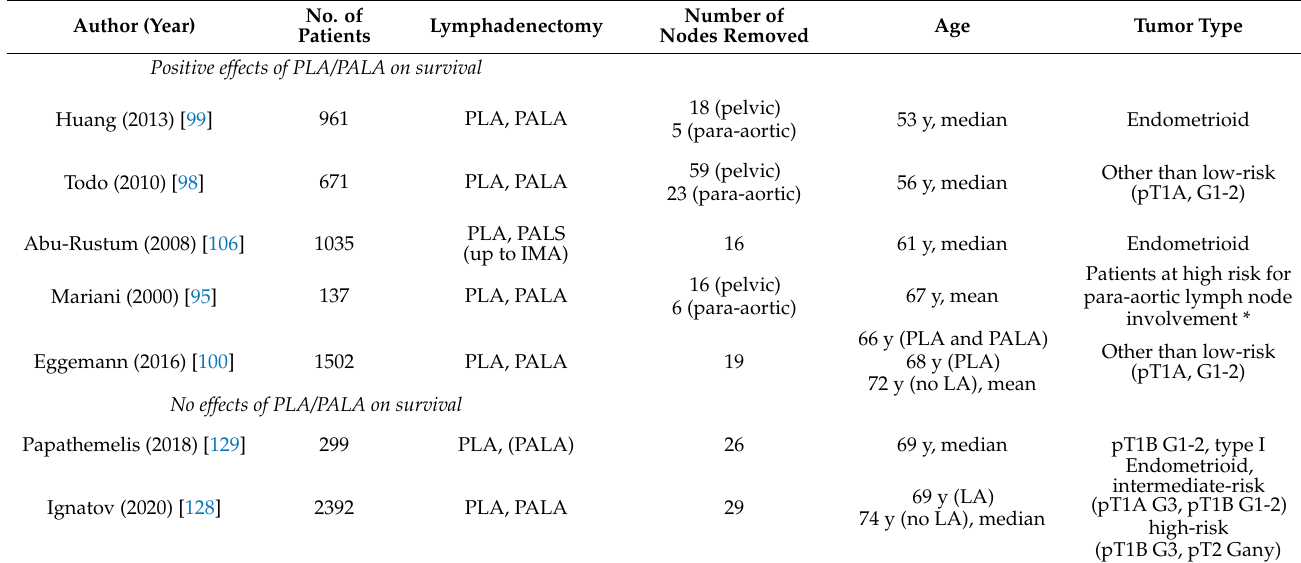
Table 3. Effects of pelvic and para-aortic lymphadenectomy by